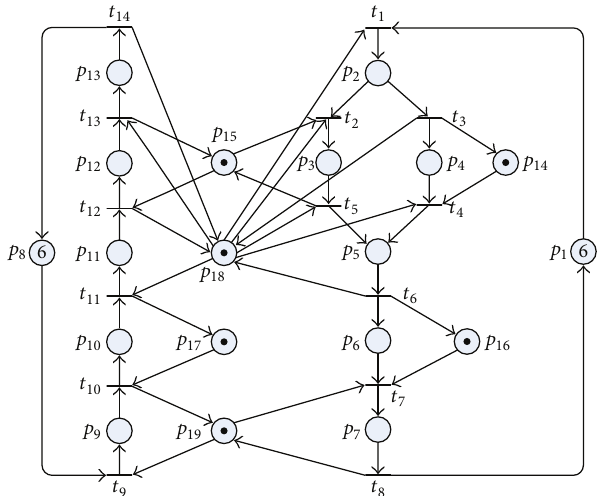
Figure 2: A classical Petri net-based S 3 PR model [32].